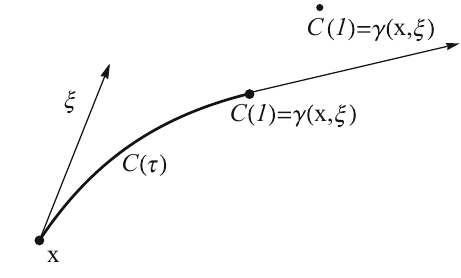
Fig. 2 The exponential